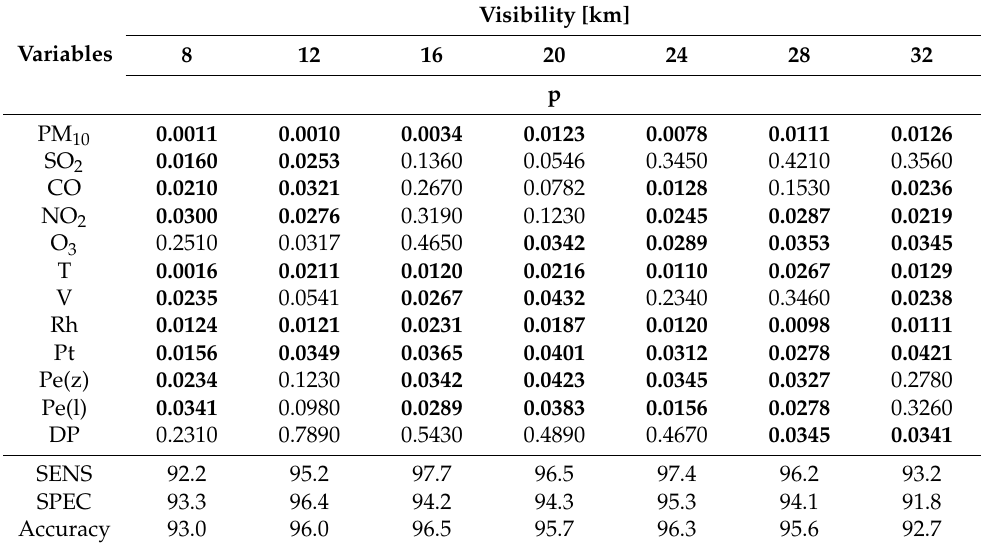
Table 1. Results of test probability (p) calculations for selected independent variables and fit of calculation results to the measurements performed in logistic regression